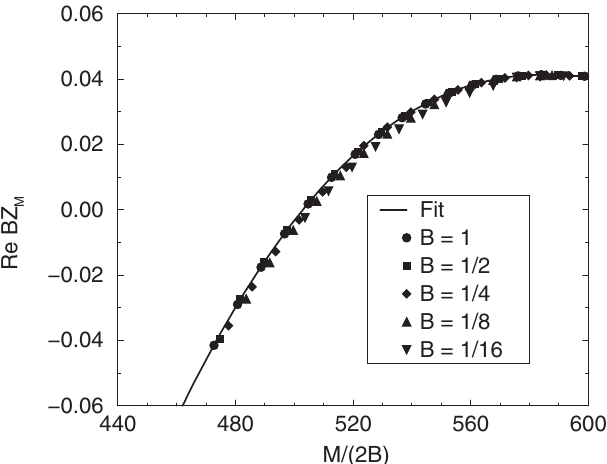
FIG. 4. Real part of resistive wall (cid:7) high order damper effec- tive impedance.